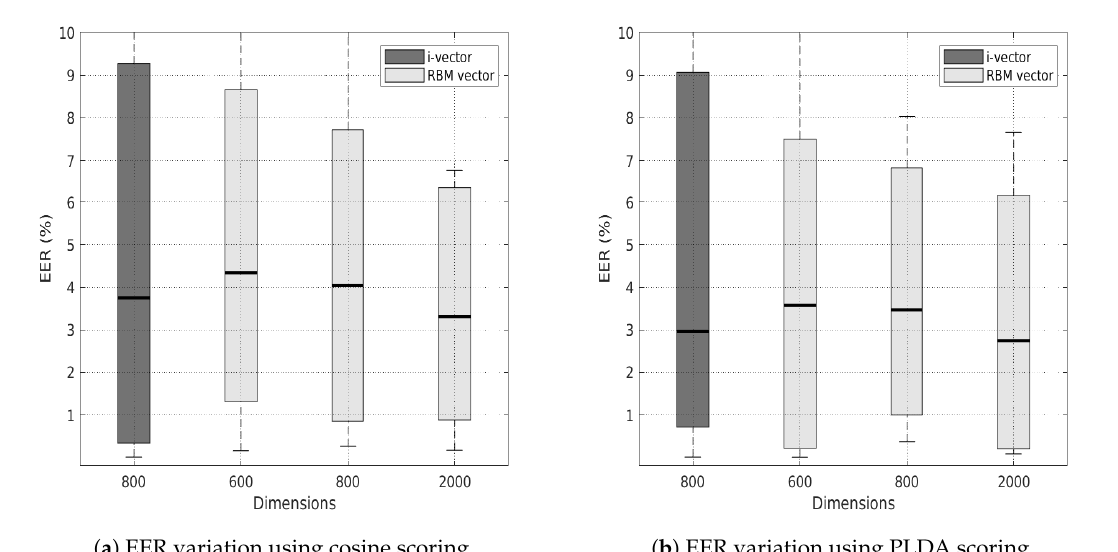
Figure 7. EER variation comparison for the proposed RBM vectors with 800 dimensional i-vectors. Different lengths of RBM vectors are